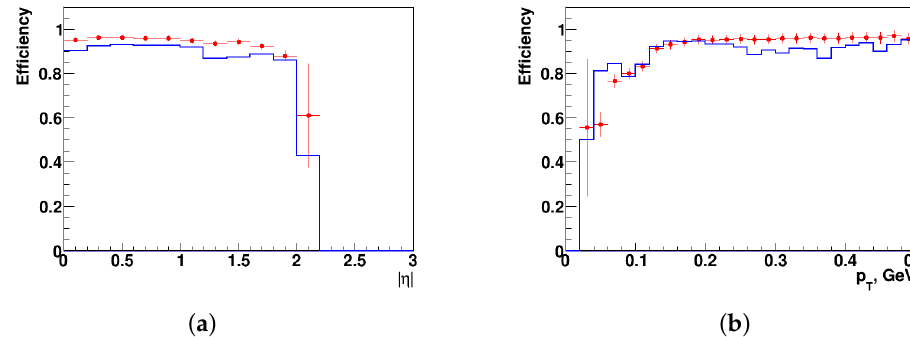
Figure 7. ( a ) Track matching efficiency vs | η | for primary and secondary tracks. ( b ) Matching efficiency vs p T for primary and secondary tracks. Notations as in Figure